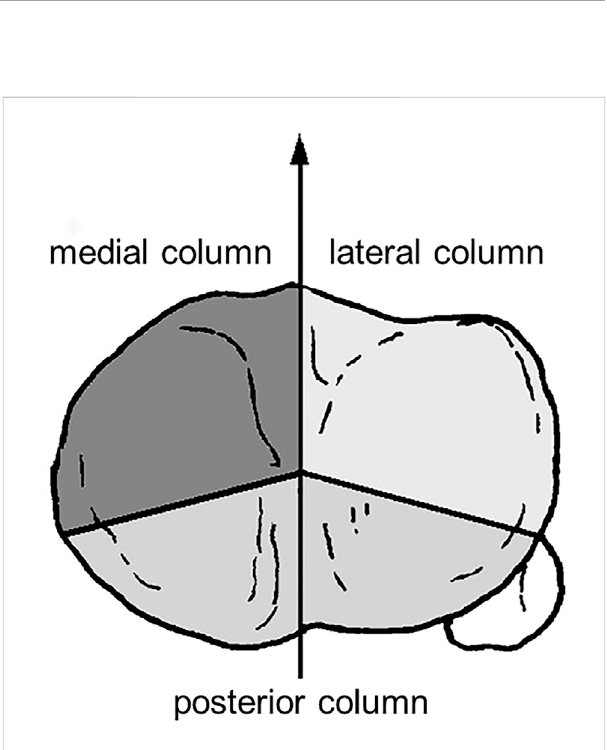
Schematic diagram of the three-column classi fi cation for tibial plateau